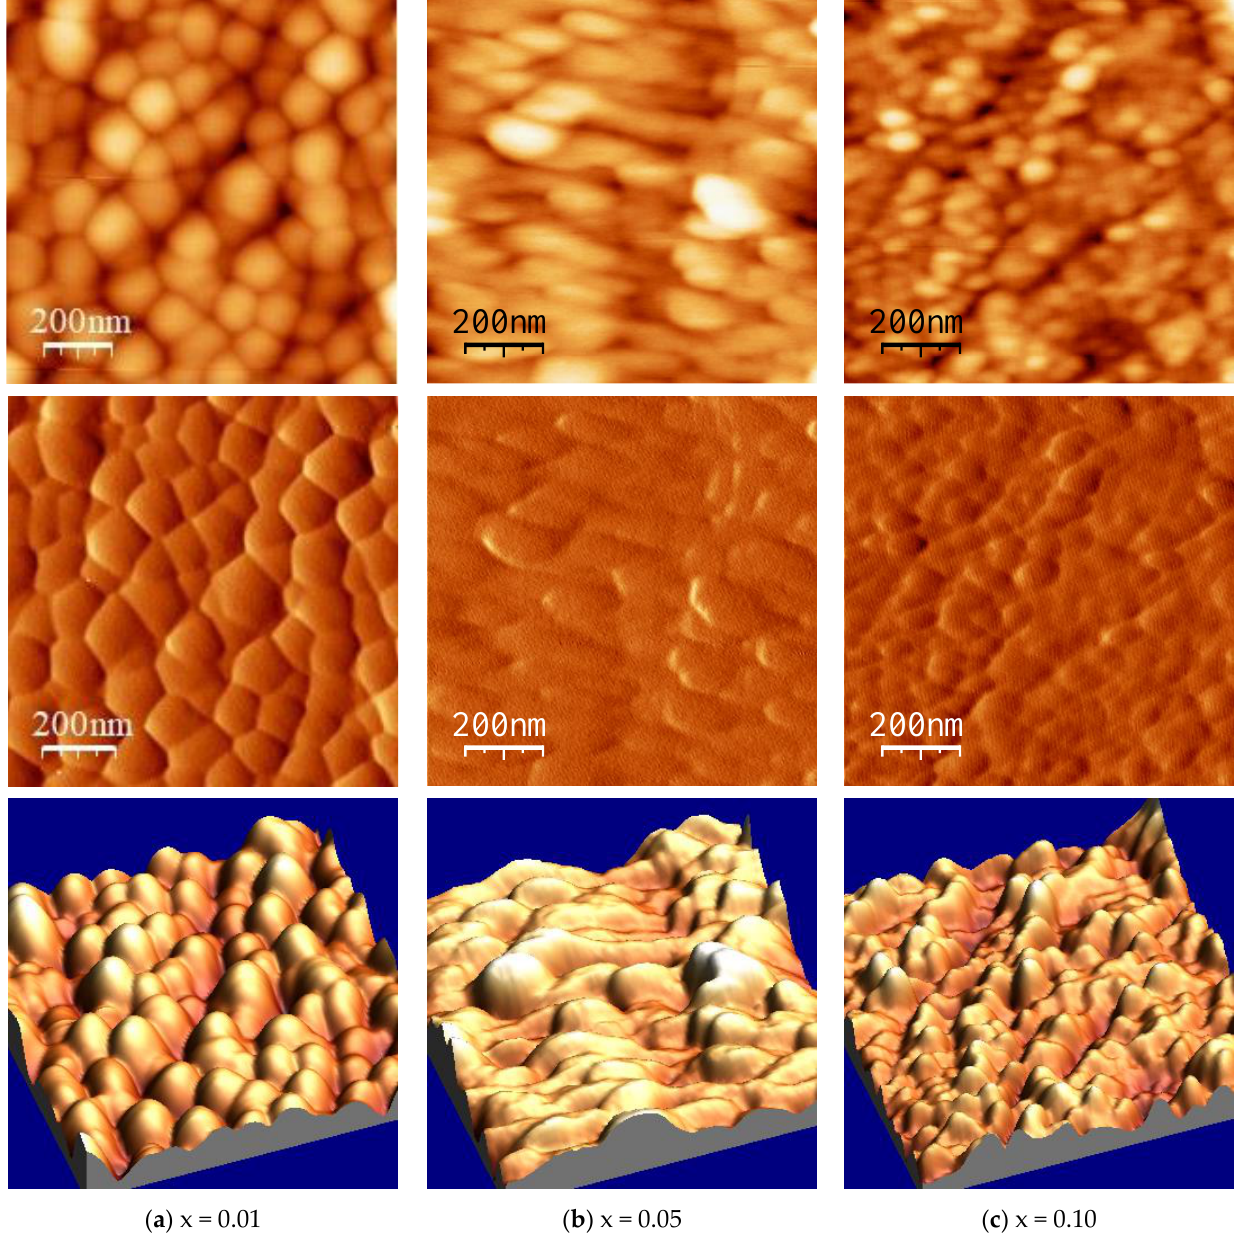
Figure 3. AFM amplitude ( top panel ), phase ( middle panel ), and 3D ( bottom panel ) topography of Sr 1-x Zn x TiO 3 thin films with x = 0.01 ( a ), 0.05 ( b ), and 0.10 ( c ). The ε (cid:48) ( T ) dependence of Sr 1-x Zn x TiO 3 thin films is shown in Figure 4 for a